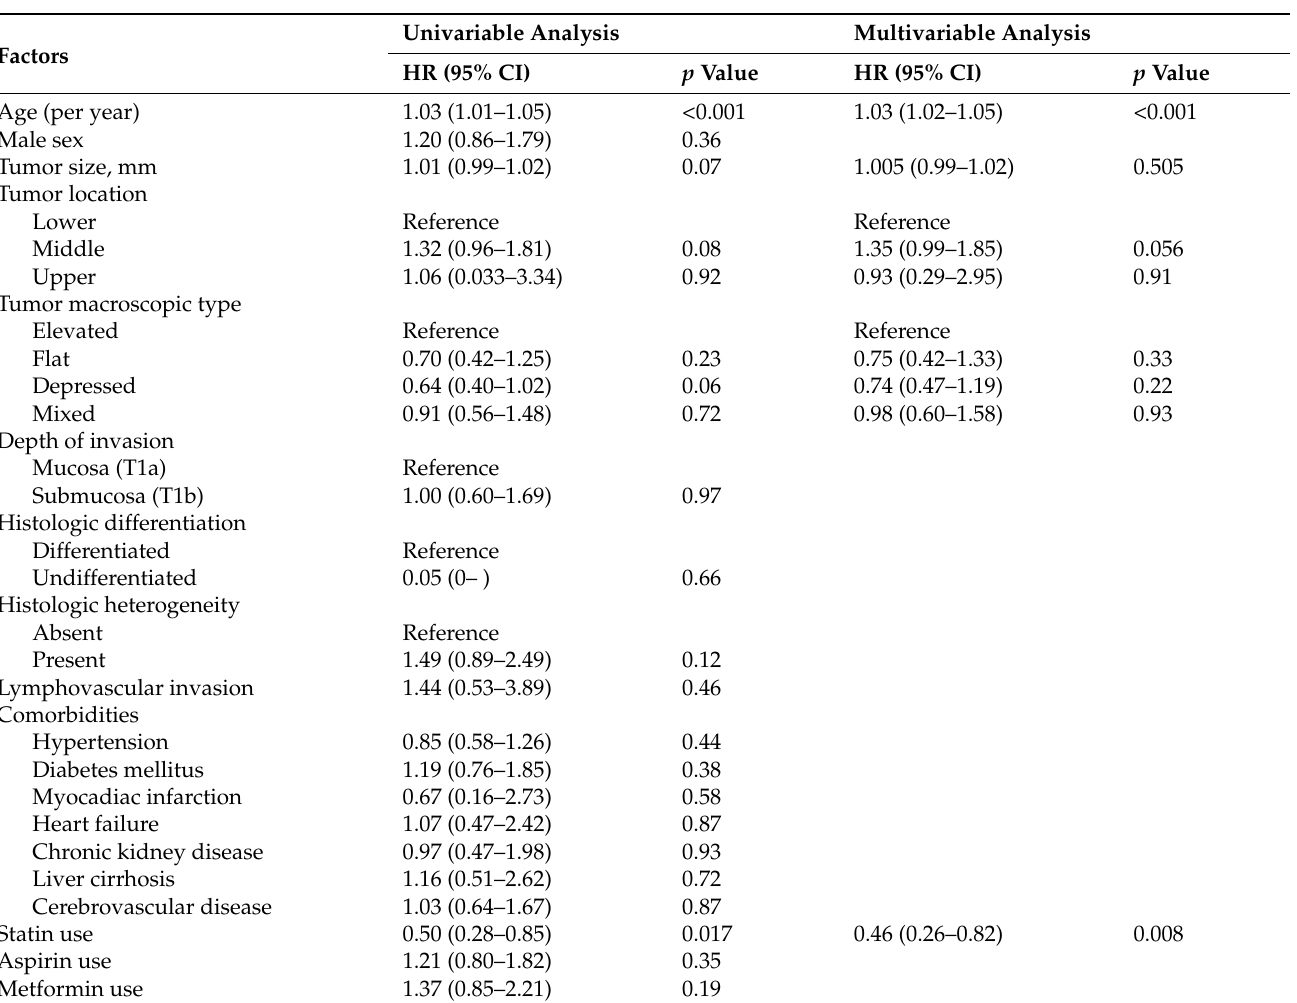
Table 2. Factors associated with metachronous gastric